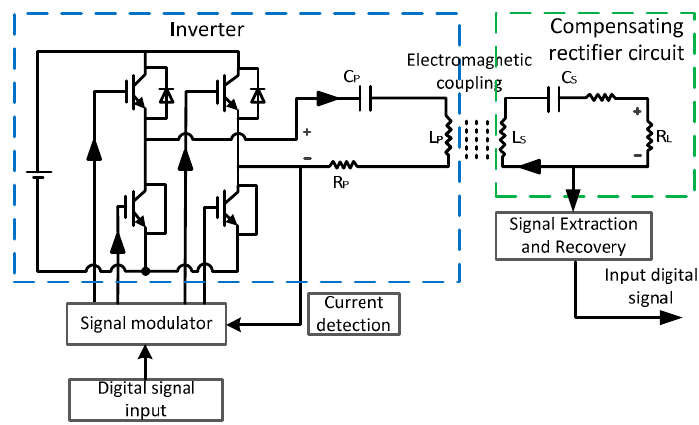
Figure 6. Schematic diagram of electromagnetic coupling signal transmission.